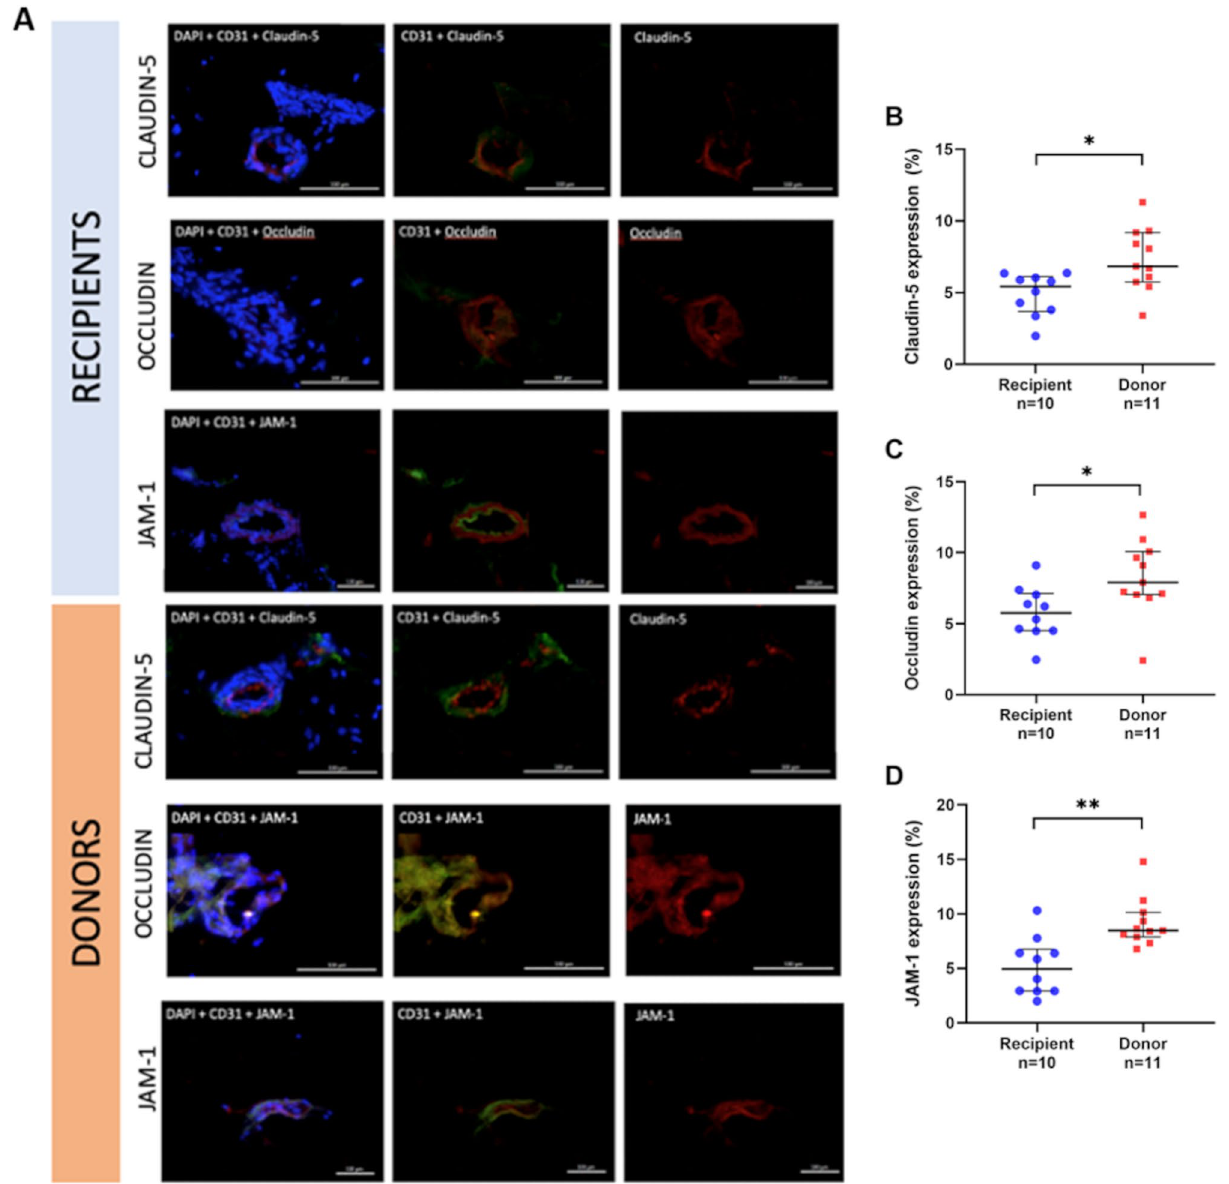
Figure 5. Tight junction protein expression in subcutaneous adipose tissue. ( A ) Immunofluorescence staining of tight junction proteins (red) claudin-5, occludin, and JAM-1, nuclear staining with DAPI (blue), endothelial marker CD31 (green) in subcutaneous tissue of kidney transplant recipients and donors. Bar = 100 µm. Expression of tight junction proteins (B) claudin-5, ( C ) occludin and ( D ) JAM-1 in subcutaneous tissue of kidney transplant recipients and donors. Results expressed in medians and interquartile range. Statistical significance * p < 0.05, ** p <